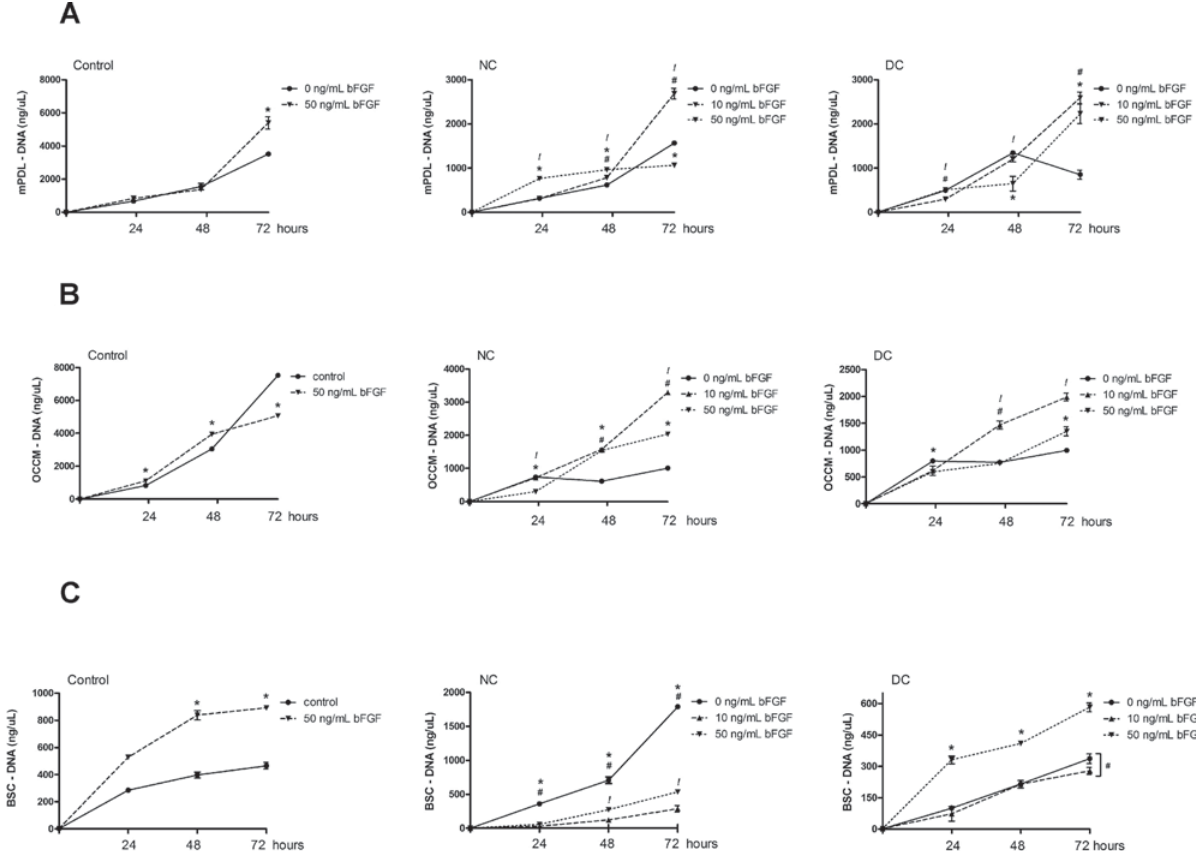
Figure 2- (cid:3)(cid:42)(cid:72)(cid:81)(cid:82)(cid:80)(cid:76)(cid:70)(cid:3)(cid:39)(cid:49)(cid:36)(cid:3)(cid:84)(cid:88)(cid:68)(cid:81)(cid:87)(cid:76)(cid:87)(cid:68)(cid:87)(cid:76)(cid:82)(cid:81)(cid:3)(cid:76)(cid:81)(cid:71)(cid:76)(cid:70)(cid:68)(cid:87)(cid:76)(cid:81)(cid:74)(cid:3)(cid:87)(cid:75)(cid:72)(cid:3)(cid:83)(cid:85)(cid:82)(cid:79)(cid:76)(cid:73)(cid:72)(cid:85)(cid:68)(cid:87)(cid:76)(cid:82)(cid:81)(cid:3)(cid:82)(cid:73)(cid:3)(cid:80)(cid:88)(cid:85)(cid:76)(cid:81)(cid:72)(cid:3)(cid:83)(cid:72)(cid:85)(cid:76)(cid:82)(cid:71)(cid:82)(cid:81)(cid:87)(cid:68)(cid:79)(cid:3)(cid:79)(cid:76)(cid:74)(cid:68)(cid:80)(cid:72)(cid:81)(cid:87)(cid:3)(cid:191)(cid:69)(cid:85)(cid:82)(cid:69)(cid:79)(cid:68)(cid:86)(cid:87)(cid:86)(cid:3)(cid:11)(cid:80)(cid:51)(cid:39)(cid:47)(cid:15)(cid:3)(cid:83)(cid:68)(cid:81)(cid:72)(cid:79)(cid:3)(cid:179)(cid:36)(cid:180)(cid:12)(cid:15)(cid:3)(cid:70)(cid:72)(cid:80)(cid:72)(cid:81)(cid:87)(cid:82)(cid:69)(cid:79)(cid:68)(cid:86)(cid:87)(cid:86)(cid:3) (cid:11)(cid:50)(cid:38)(cid:38)(cid:48)(cid:15)(cid:3)(cid:83)(cid:68)(cid:81)(cid:72)(cid:79)(cid:3)(cid:179)(cid:37)(cid:180)(cid:12)(cid:3)(cid:68)(cid:81)(cid:71)(cid:3)(cid:69)(cid:82)(cid:81)(cid:72)(cid:3)(cid:80)(cid:68)(cid:85)(cid:85)(cid:82)(cid:90)(cid:3)(cid:86)(cid:87)(cid:85)(cid:82)(cid:80)(cid:68)(cid:79)(cid:3)(cid:70)(cid:72)(cid:79)(cid:79)(cid:86)(cid:3)(cid:11)(cid:37)(cid:48)(cid:54)(cid:38)(cid:15)(cid:3)(cid:83)(cid:68)(cid:81)(cid:72)(cid:79)(cid:3)(cid:179)(cid:38)(cid:180)(cid:12)(cid:15)(cid:3)(cid:68)(cid:70)(cid:70)(cid:82)(cid:85)(cid:71)(cid:76)(cid:81)(cid:74)(cid:3)(cid:87)(cid:82)(cid:3)(cid:87)(cid:75)(cid:72)(cid:3)(cid:72)(cid:91)(cid:83)(cid:72)(cid:85)(cid:76)(cid:80)(cid:72)(cid:81)(cid:87)(cid:68)(cid:79)(cid:3)(cid:70)(cid:82)(cid:81)(cid:71)(cid:76)(cid:87)(cid:76)(cid:82)(cid:81)(cid:86)(cid:17)(cid:3)(cid:38)(cid:72)(cid:79)(cid:79)(cid:86)(cid:3)(cid:90)(cid:72)(cid:85)(cid:72)(cid:3)(cid:83)(cid:79)(cid:68)(cid:87)(cid:72)(cid:71)(cid:3)(cid:82)(cid:81)(cid:87)(cid:82)(cid:3) dentin slices on which bFGF (10 and 50 ng) was applied topically both with and without previous acid conditioning. Cells were grown in complete culture medium for 24, 48 and 72 h. In positive control samples, cells were plated on tissue culture plastic (no dentin slices) and stimulated with 50 ng/mL of bFGF and genomic DNA collected at the same periods. The different symbols indicate mean and the vertical lines indicate the standard deviation of genomic DNA quantity from three independent experiments, measured in triplicate at each time (cid:83)(cid:82)(cid:76)(cid:81)(cid:87)(cid:3)(cid:11)(cid:13)(cid:3)(cid:76)(cid:81)(cid:71)(cid:76)(cid:70)(cid:68)(cid:87)(cid:72)(cid:86)(cid:3)(cid:83)(cid:31)(cid:19)(cid:17)(cid:19)(cid:24)(cid:3)(cid:70)(cid:82)(cid:81)(cid:87)(cid:85)(cid:82)(cid:79)(cid:3) vs (cid:3)(cid:24)(cid:19)(cid:3)(cid:81)(cid:74)(cid:18)(cid:80)(cid:47)(cid:3)(cid:69)(cid:41)(cid:42)(cid:41)(cid:15)(cid:3)(cid:6)(cid:3)(cid:76)(cid:81)(cid:71)(cid:76)(cid:70)(cid:68)(cid:87)(cid:72)(cid:86)(cid:3)(cid:83)(cid:31)(cid:19)(cid:17)(cid:19)(cid:24)(cid:3)(cid:70)(cid:82)(cid:81)(cid:87)(cid:85)(cid:82)(cid:79)(cid:3) vs (cid:3)(cid:20)(cid:19)(cid:3)(cid:81)(cid:74)(cid:18)(cid:80)(cid:47)(cid:3)(cid:69)(cid:41)(cid:42)(cid:41)(cid:15)(cid:3)(cid:68)(cid:81)(cid:71)(cid:3)(cid:4)(cid:3)(cid:76)(cid:81)(cid:71)(cid:76)(cid:70)(cid:68)(cid:87)(cid:72)(cid:86)(cid:3)(cid:83)(cid:31)(cid:19)(cid:17)(cid:19)(cid:24)(cid:3)(cid:20)(cid:19)(cid:3)(cid:81)(cid:74)(cid:18)(cid:80)(cid:47)(cid:3)(cid:69)(cid:41)(cid:42)(cid:41)(cid:3) vs 50 ng/mL